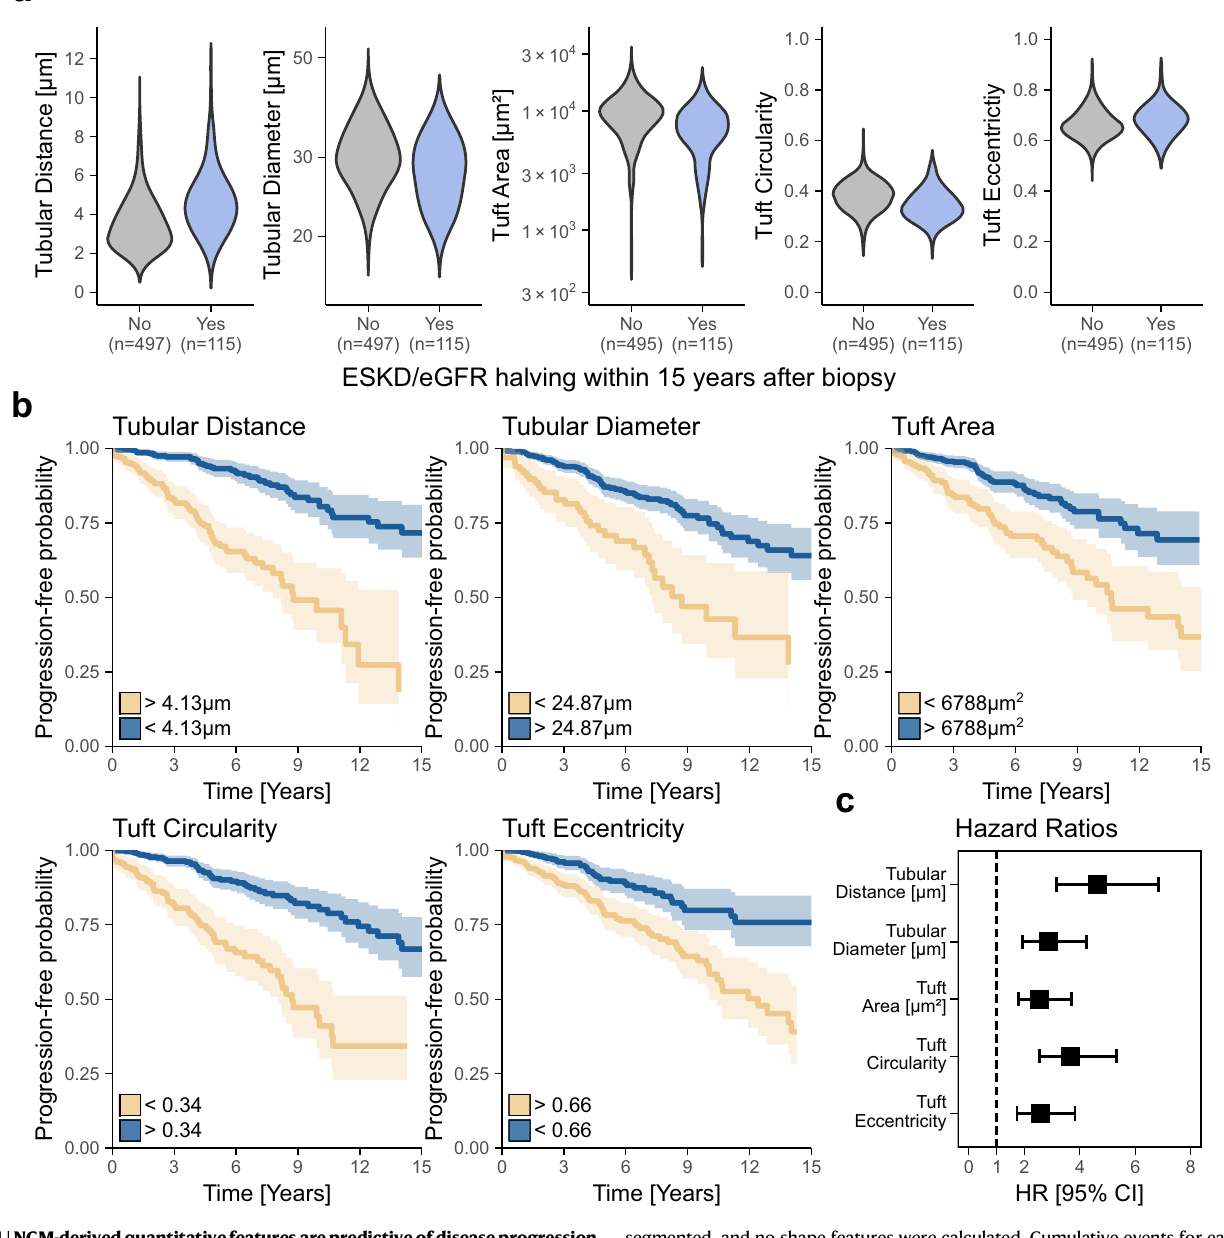
segmented, and no shape features were calculated. Cumulative events for each group in the univariate Cox proportional hazard models are provided in Supp. Table9. c Hazardratios(centre)andtheir95%con fi denceinterval(errorbars)from the univariate Cox proportional hazard models of the respective features. Source data are provided as a Source Data fi le. ESKD end-stage kidney disease,